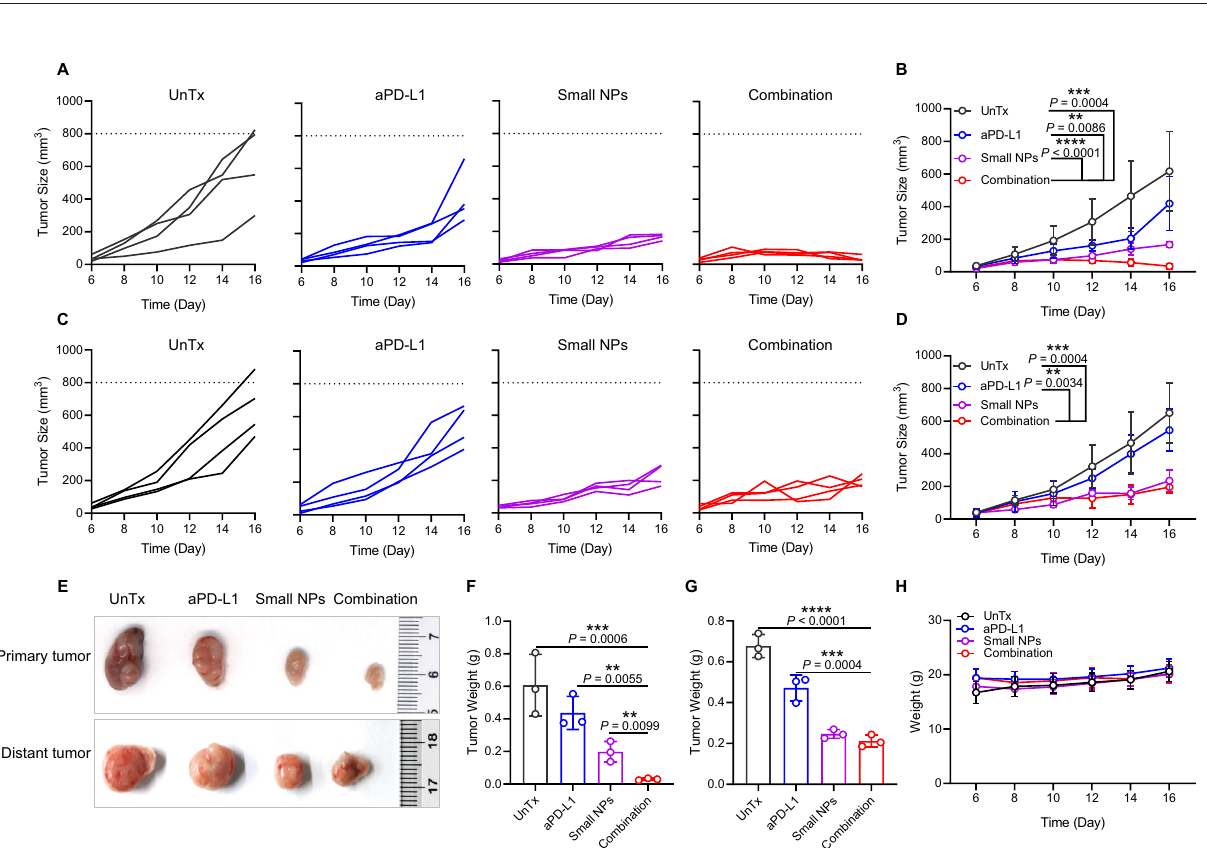
Fig. 7 YCW NPs in combination with PD-L1 blockade inhibit metastatic tumor growth. A Schematic diagram of applying combination therapy to induce anti-tumor immune responses systemically. B – C Individual ( B ) and average ( C ) tumor growth curves in four groups of primary tumors, including UnTx group ( n = 4), aPD-L1 group ( n = 4), small NPs group ( n = 6), combination group ( n = 6). D – E Individual ( D ) and average ( E ) tumor growth curves of distant tumors ( n = 4) in four different groups. F Fluorescence imaging of B16-luc established mice on day 8, 11, 14. G Representative photographs of mice in untreated and combination group on day 14. H Photographs and I – J weight of primary tumors and distant tumors within 20 days (UnTx: n = 4; aPD-L1: n = 3; Small NPs: n = 4; Combine: n = 4). K Flow cytometry plots of CD4 + T cells and CD8 + T cells of distant tumors in four groups. L Corresponding quantitative analysis of CD8 + T cells of distant tumor. M Corresponding quantitative analysis of CD4 + T cells of distant tumor ( n = 4). ( N ) Bioluminescence imaging of lung metastasis established by B16-luc in vivo on day 10, 13, 16 in untreated and combination groups. O Imaging of whole lung tissue ex vivo. ( P ) Number of tumors in lung ( n = 3). Statistical signi fi cance between different groups was obtained by Student ’ s t tests (two-tailed) P and one-way ANOVA using the Tukey post-test ( C , E , I , J , L , M ). **** P < 0.0001; *** P < 0.005; ** P < 0.01; * P < 0.05. Data are means ± SD.